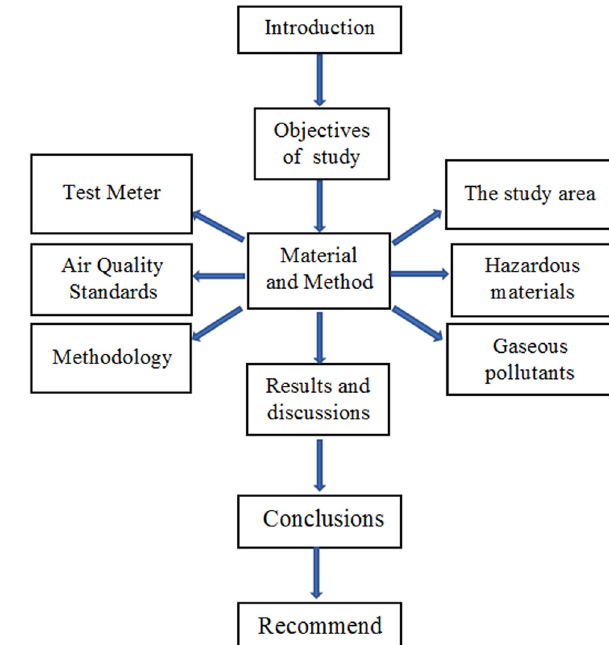
Figure 2: Gases measuring device.